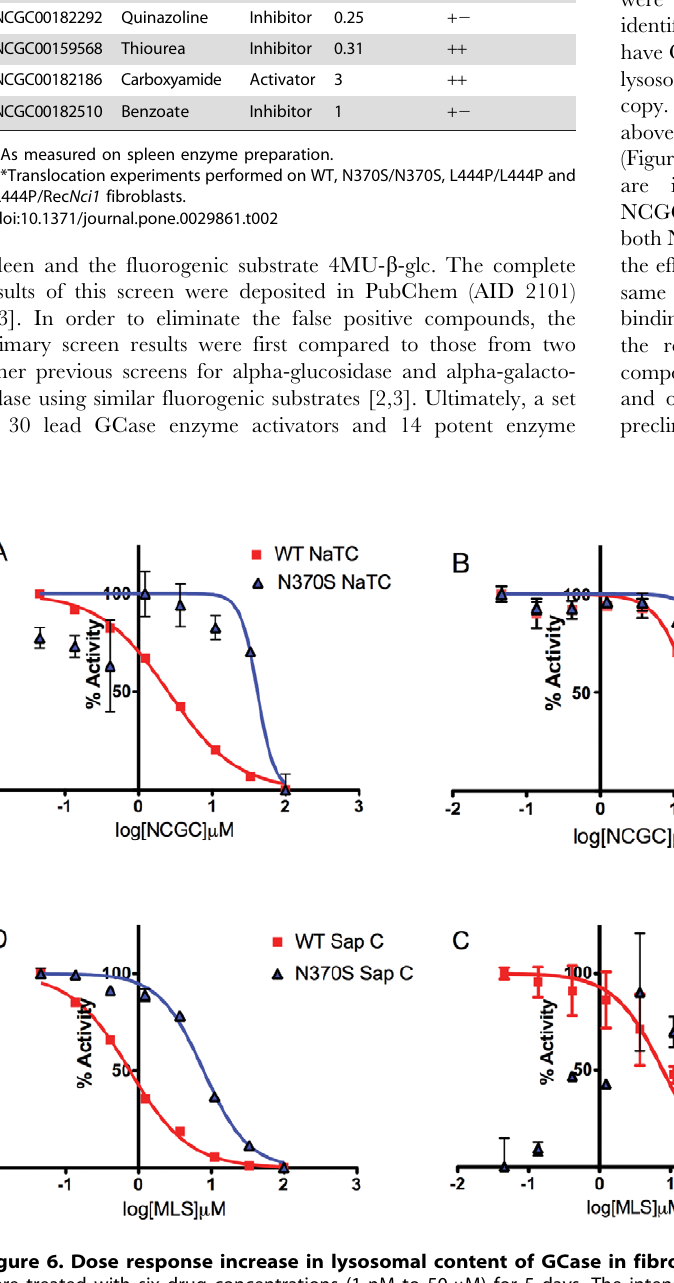
Figure 6. Dose response increase in lysosomal content of GCase in fibroblasts treated with selected identified compounds. Cells were treated with six drug concentrations (1 nM to 50 m M) for 5 days. The intensity of GCase staining in the lysosomes was measured using an automatic fluorescent microscope. The slope of dose dependent increase in fluorescence was plotted and statistically significant slopes are labeled with (*). Some compounds, including the activator NCGC00182510, were able to increase the lysosomal content of both N370S and L444P mutant enzymes. Some compounds were found to be toxic at the highest concentration and that point was removed from calculations. doi:10.1371/journal.pone.0029861.g006 PLoS ONE |